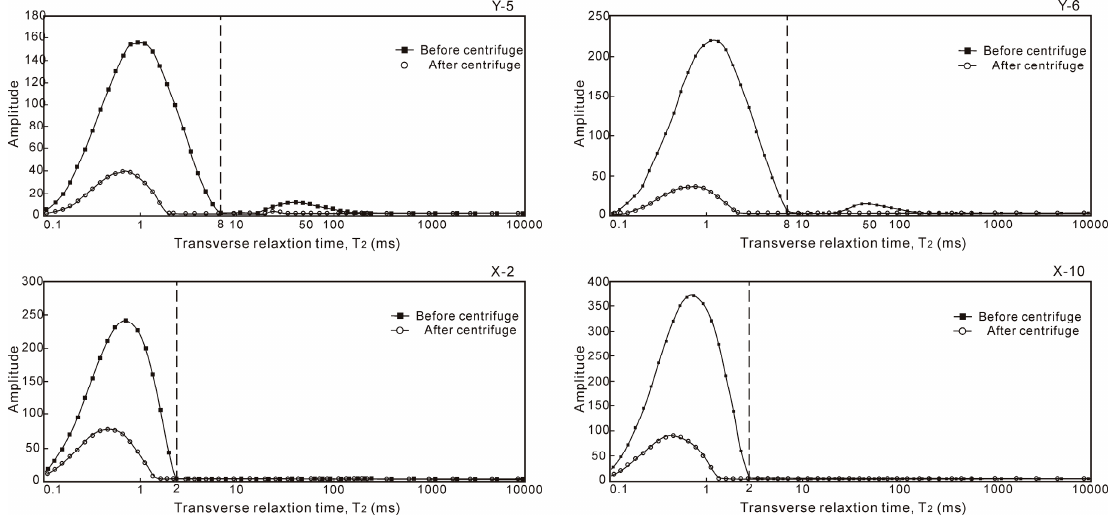
Figure 8. Typical nuclear magnetic resonance (NMR) T 2 spectra of transitional Longtan Shale samples from YV-1 and XD-1.